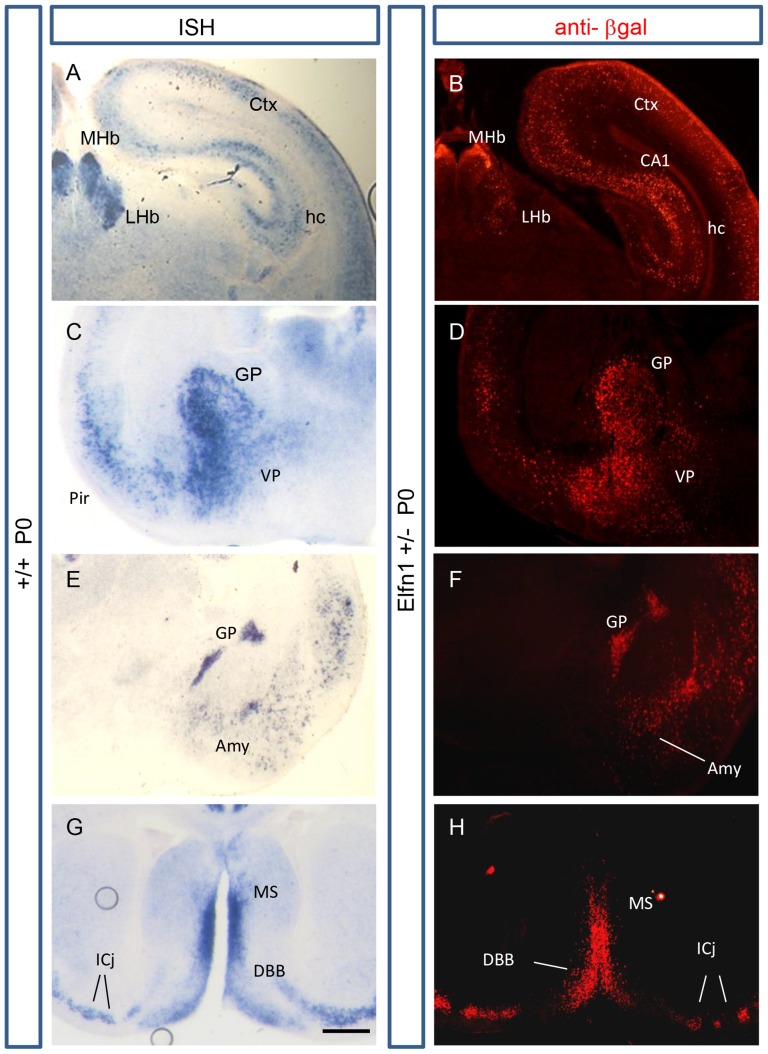
β-gal immunohistochemistry replicates Elfn1 in-situ hybridisation staining patterns.Comparative coronal sections of β-gal immunoreactivity in an Elfn1+/− mouse brain and in situ hybridisation staining using an Elfn1 probe in a wildtype brain, both at P0. (A,B) Strong staining is evident in the dorsal MHb and the central region of the LHb. Scattered cells in the cortex and hippocampus are also observed, in a layer-specific manner in hippocampus, with particularly strong staining in the CA1 region. (C,D) Strong staining of Elfn1-positive cells are identified with both methods in the globus pallidus and ventral pallidum, with intense staining specifically in the lateral cells of the GP. (E,F) The amygdala, piriform cortex, and the caudal region of the globus pallidus exhibit comparable staining. (G,H) Intense staining in the medial septum, and to a lesser extent in the DBB, is evident. The forming Islands of Calleja also show staining with both methods of Elfn1 detection. amy, amygdala; CA1, CA1 region of the hippocampus; ctx, cortex; DBB, diagonal band of Broca; GP, globus pallidus; hc, hippocampus; ICj; islands of Calleja; LH, lateral hypothalamus; LHb, lateral habenula; MHb, medial habenula; MS, medial septum; Pir, pirform cortex; VP, ventral palidum. Scale bar: 300 microns.